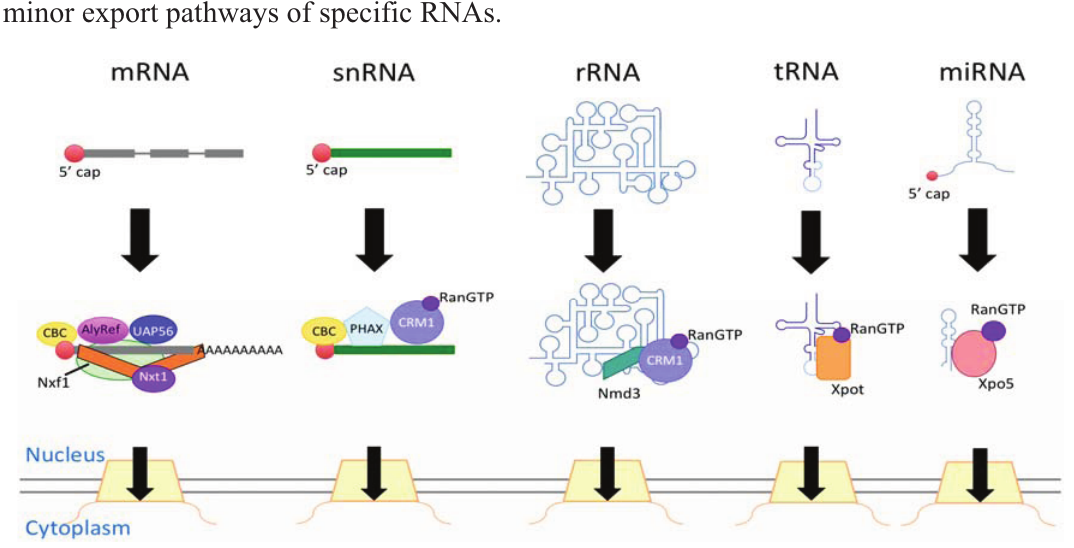
Figure 1. The major routes of RNA export. The transcripts undergo processing and associate with export receptors. This figure shows the representative export receptors for each